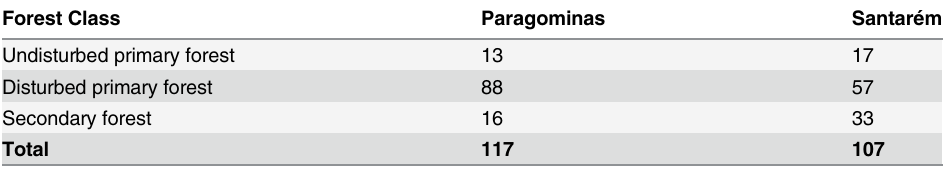
Table 1. Number of sampled plots (0.25ha) in each study